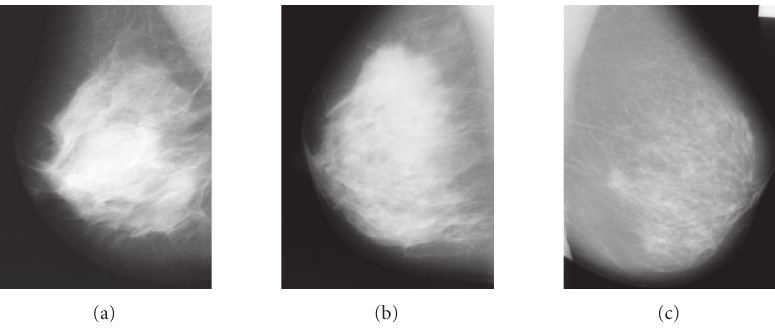
Figure 1: (a) Benign mammogram in training set mdb001; (b) normal mammogram in training set mdb003; and (c) malignant mammo- gram in training set mdb058.